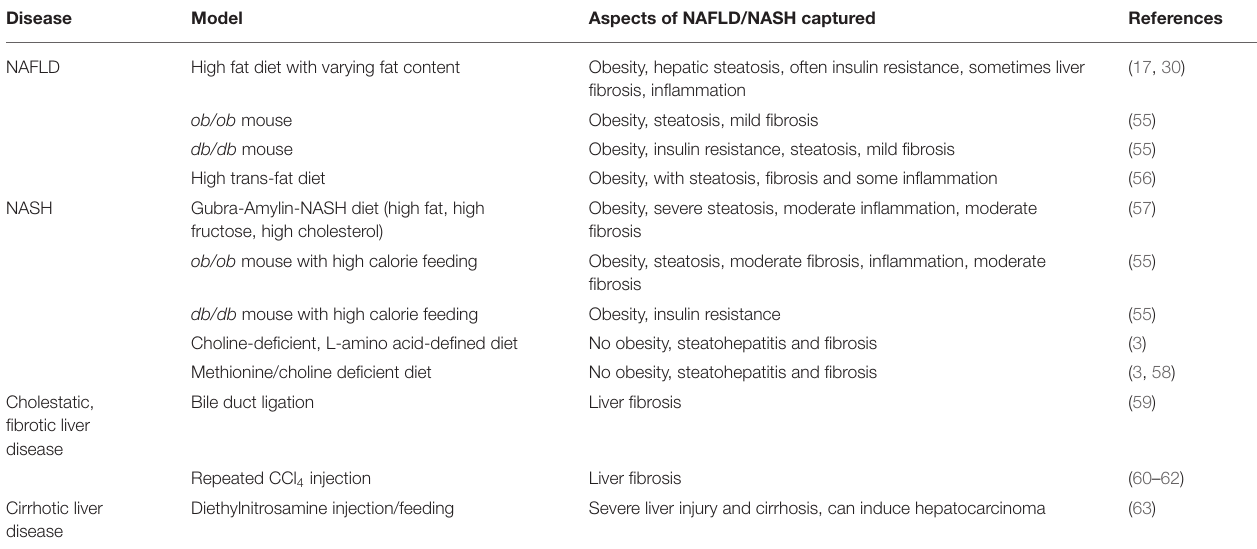
TABLE 1 | Rodent models for the study of NAFLD.